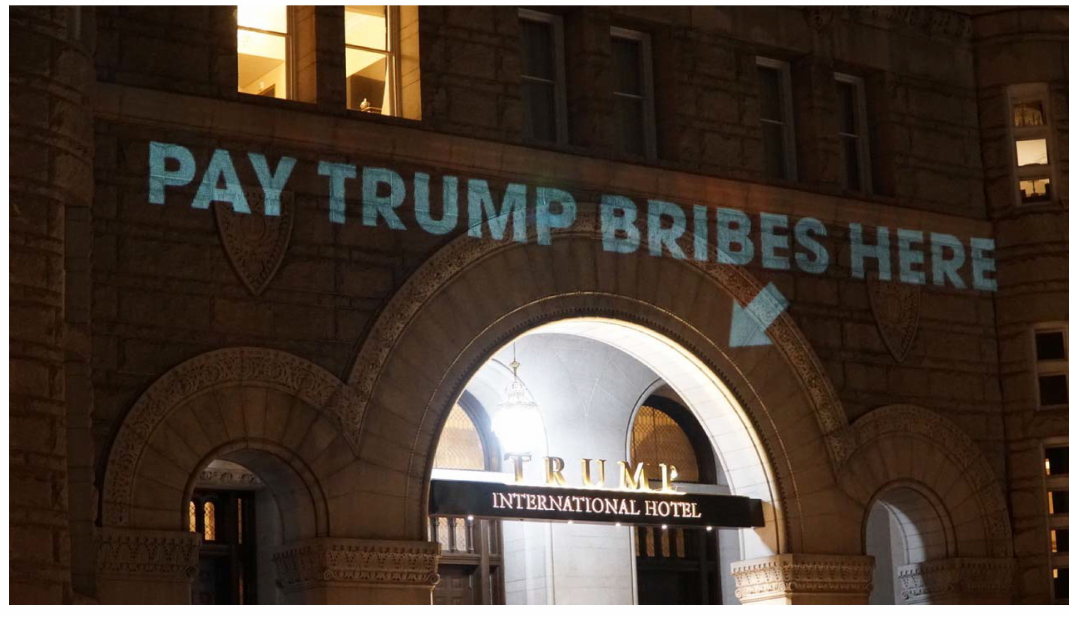
Figure 4 A message projected onto the façade of the Trump International Hotel in Washington, DC. (Projection by Robin Bell, photography by Liz